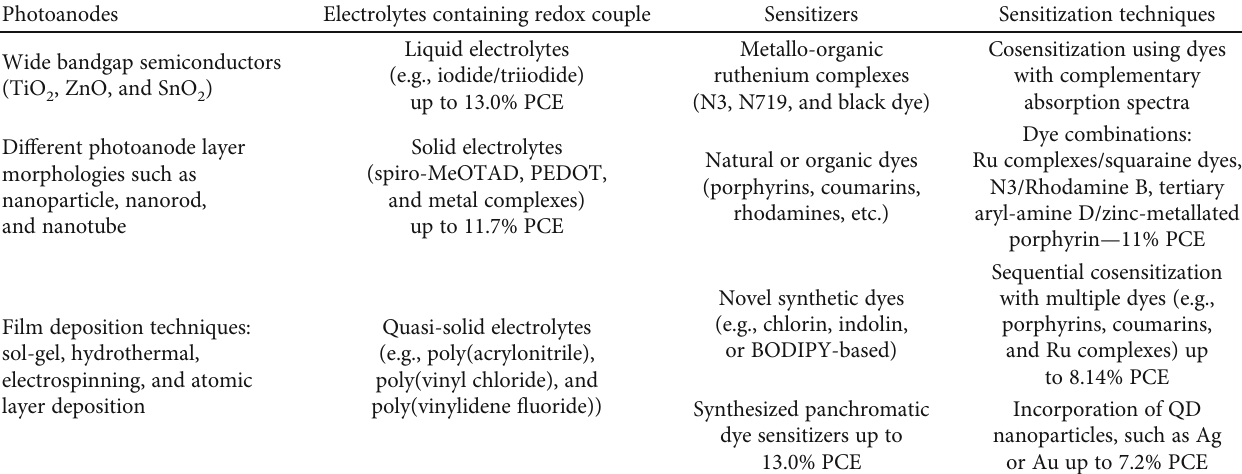
Table 2: Novel materials and methods used for the development of